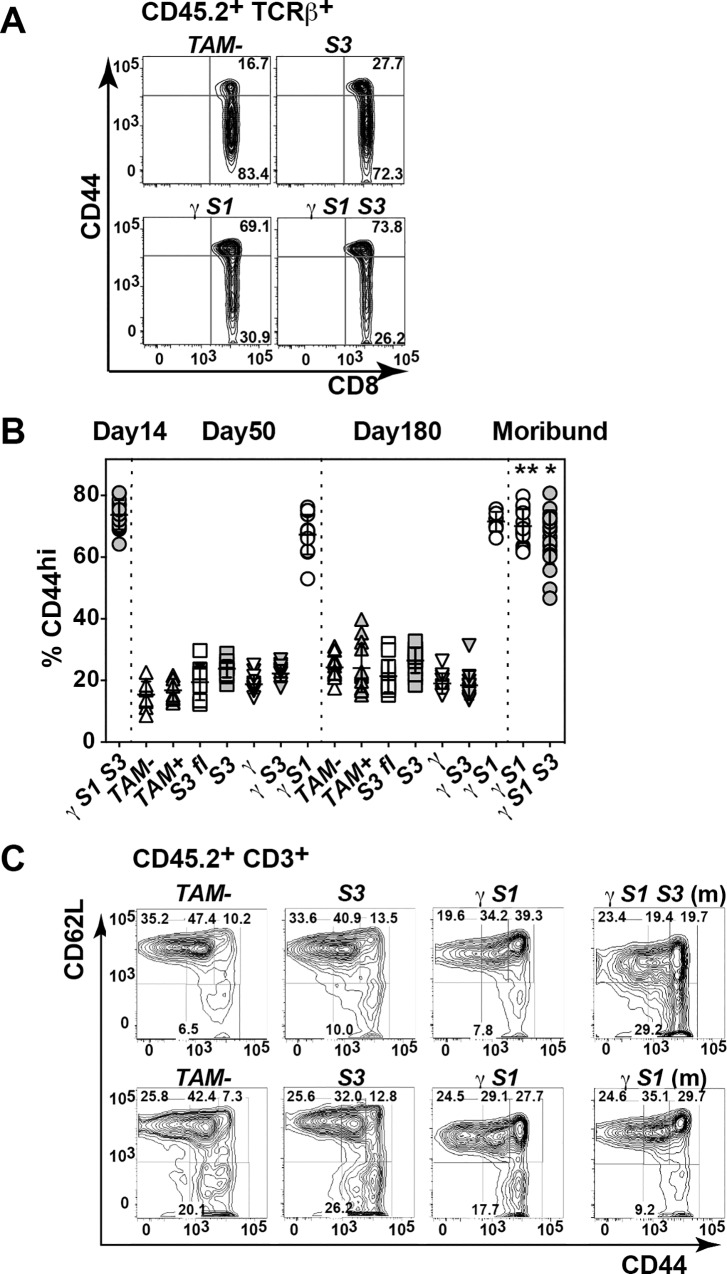
CD44 expression on T cells in mice lacking SOCS proteins.(A) Representative flow cytometry profiles of CD8 and CD44 expression on TCRβ+ T cells in spleens mice 14d after tamoxifen or vehicle treatment. (B) Proportions of CD8+ T cells expressing high levels of CD44 (CD44hi) in spleens of mice at the times indicated after tamoxifen or vehicle treatment. (C) Proportions of naïve (CD44- CD62L+), central memory (CD44+ CD62L+) and effector memory (CD44+ CD62L-) CD3+ T cells in spleens of mice 50d (top panels) or 180d (bottom) after tamoxifen or vehicle treatment (m, moribund). Mean ± SD is shown with * p<0.05 for comparison of γS1S3 (moribund) with all genotypes at day 50 except γS1 (non-moribund day 50). ** p<0.05 for comparison of γS1 (moribund) with all genotypes at day 180 except γS1 (non-moribund, day 180), one-way ANOVA with Tukey’s multiple comparisons test, n = 7–20 mice per group.